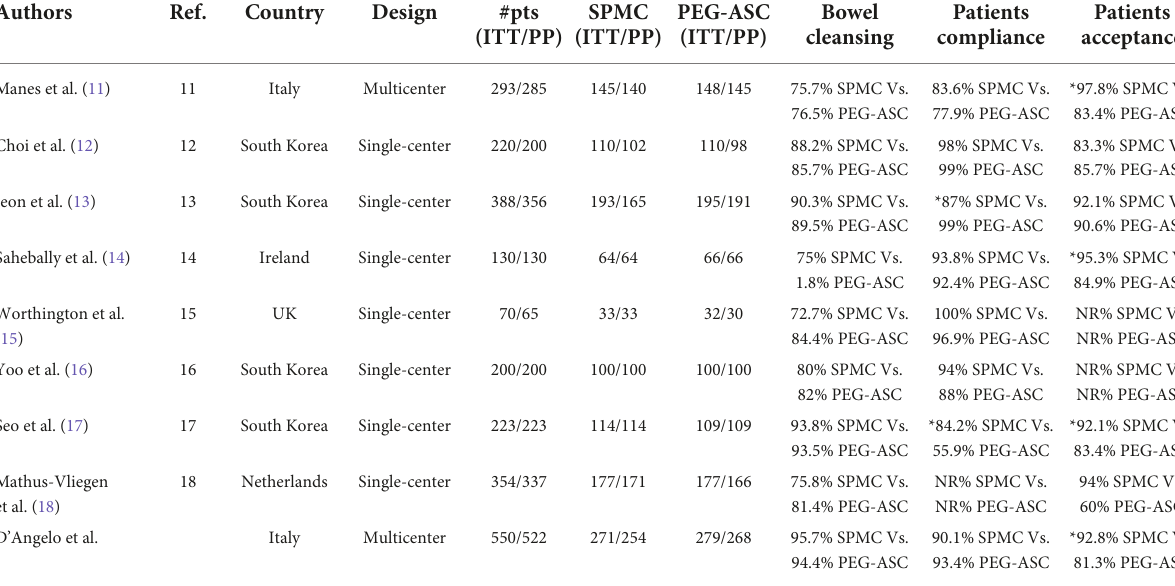
TABLE 5 Randomized trials comparing sodium picosulphate plus magnesium citrate (SPMC) with polyethylene glycol plus ascorbic acid (PEG-ASC). Authors